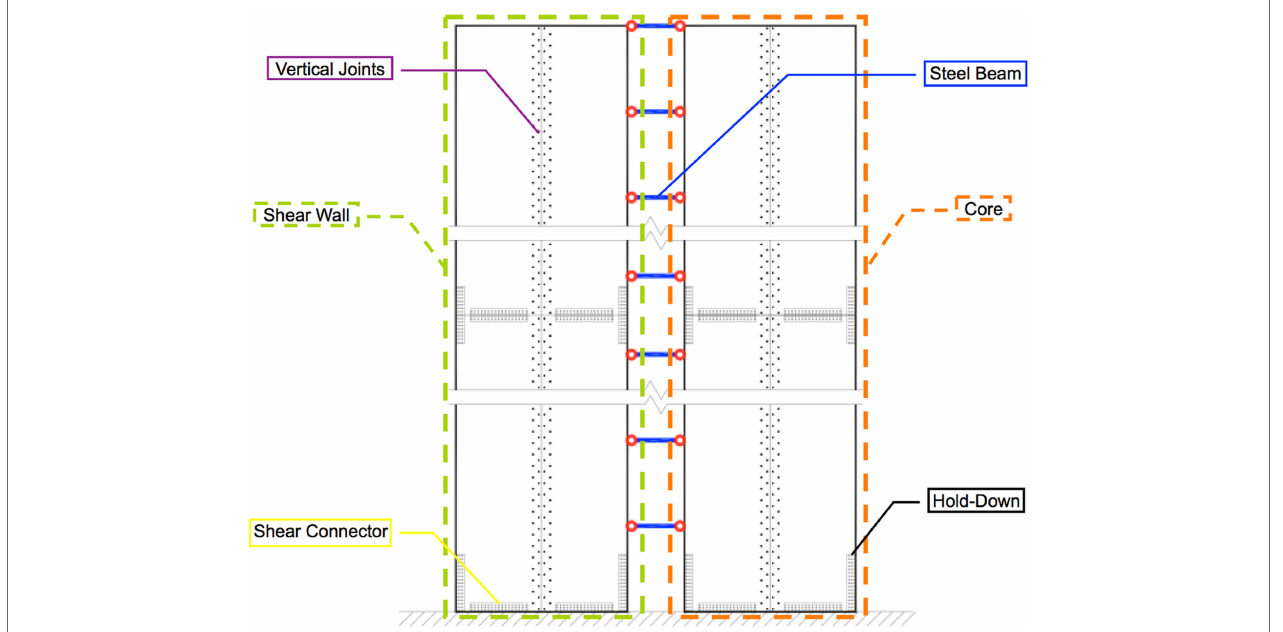
FigUre 1 | Schematic diagram of lateral load-resisting